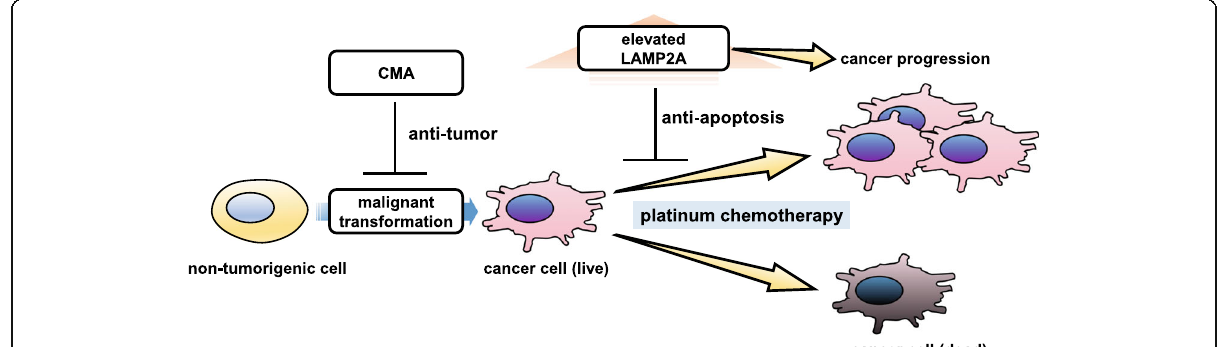
Fig. 3 Elevated LAMP2A in chemoresistance in NSCLC. Elevated LAMP2A is associated with resistance to platinum-based chemotherapy through anti-apoptotic property of CMA, resulting in cancer